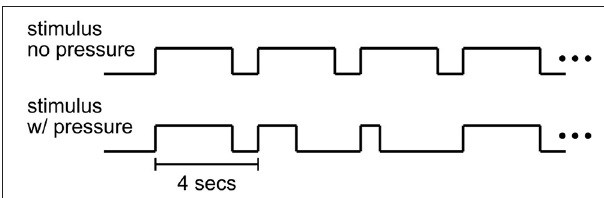
FIGURE 2 | Stimulus timecourse. In Ac emphasized (no pressure) runs, subjects could respond anytime within a 3s period of stimulus presentation. In SpAc (pressure) runs, half of the trials required a response within a shorter stimulus duration (between 400 and 1,000ms).